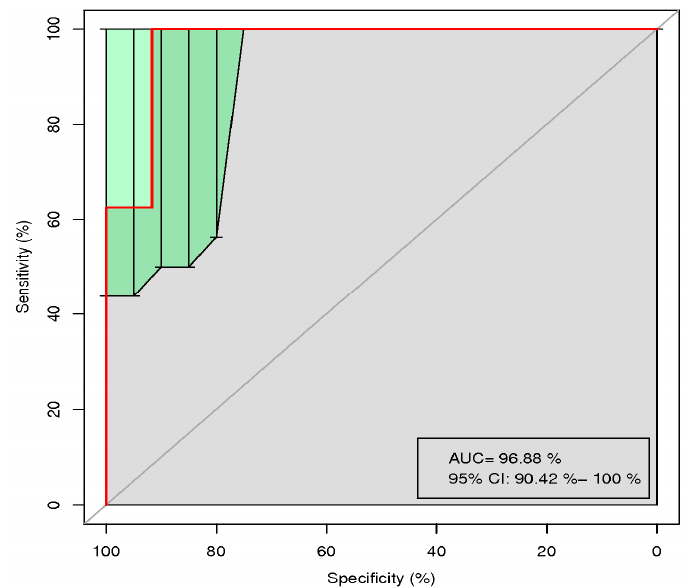
Figure 5. The neonatal gut microbiota composition is a potential biomarker of neonatal jaundice. Random forest analysis of six microbial genera yielded an AUC of 96.88% (95% CI, 90.42%–100%), indicating a significant difference between the neonatal jaundice group and the healthy controls.